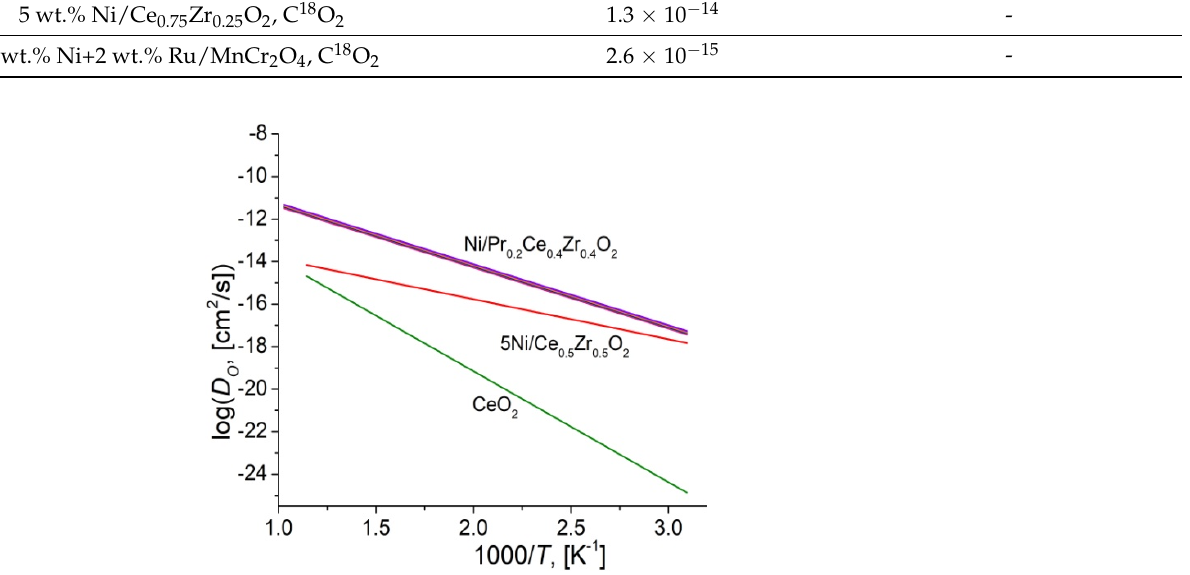
Figure 1. Temperature dependencies of oxygen self-diffusion coefficients D O for ceria and ceria-zirconia based samples prepared via modified Pechini route. Table 1. Oxygen self-diffusion coefficients in the bulk ( D bulk ) and along grain boundaries ( D interface ) at 700°C [19,24,68,69,104–109].